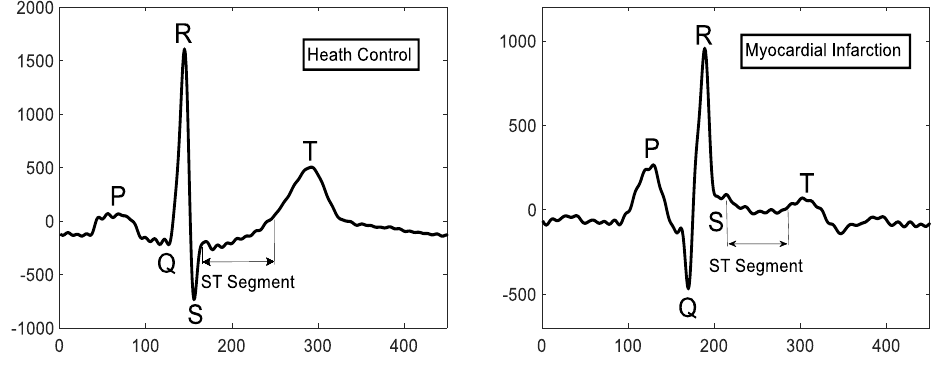
Figure 1. Electrocardiogram (ECG) signal of myocardial infarction.